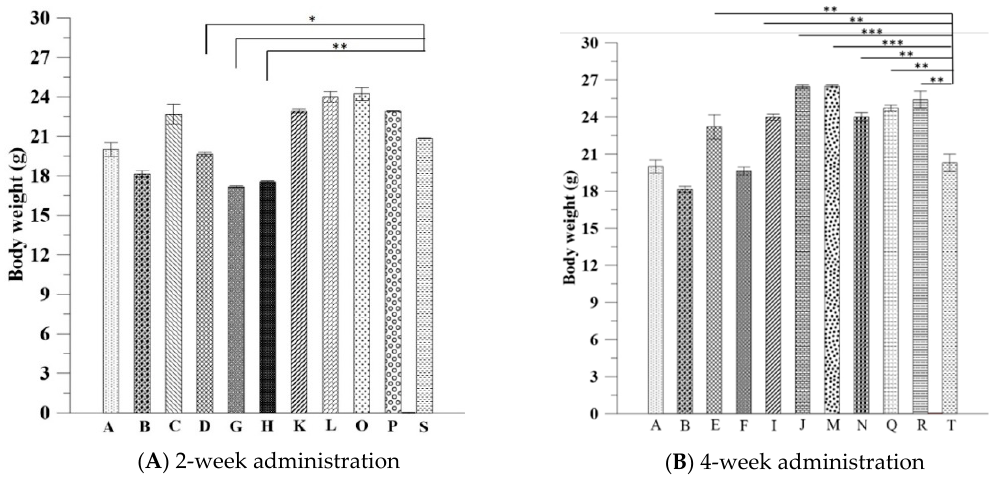
Figure 4. The weight change ratio of mice in each experimental group. Mice that received Asta-lipo gained weight normally, whereas mice in Groups O–R that received repeated alcohol intake lost weight, which was similar to the result in the untreated mice in Group B (Groups which received 2-week p.o and i.p. administration with Asta-lipo or pure liposomes were compared to Group S; Groups which received 4-week p.o and i.p. administration with Asta-lipo or pure liposomes were compared to Group T; N = 4, * P < 0.05, ** P < 0.01 and *** P < 0.001, by ANOVA).